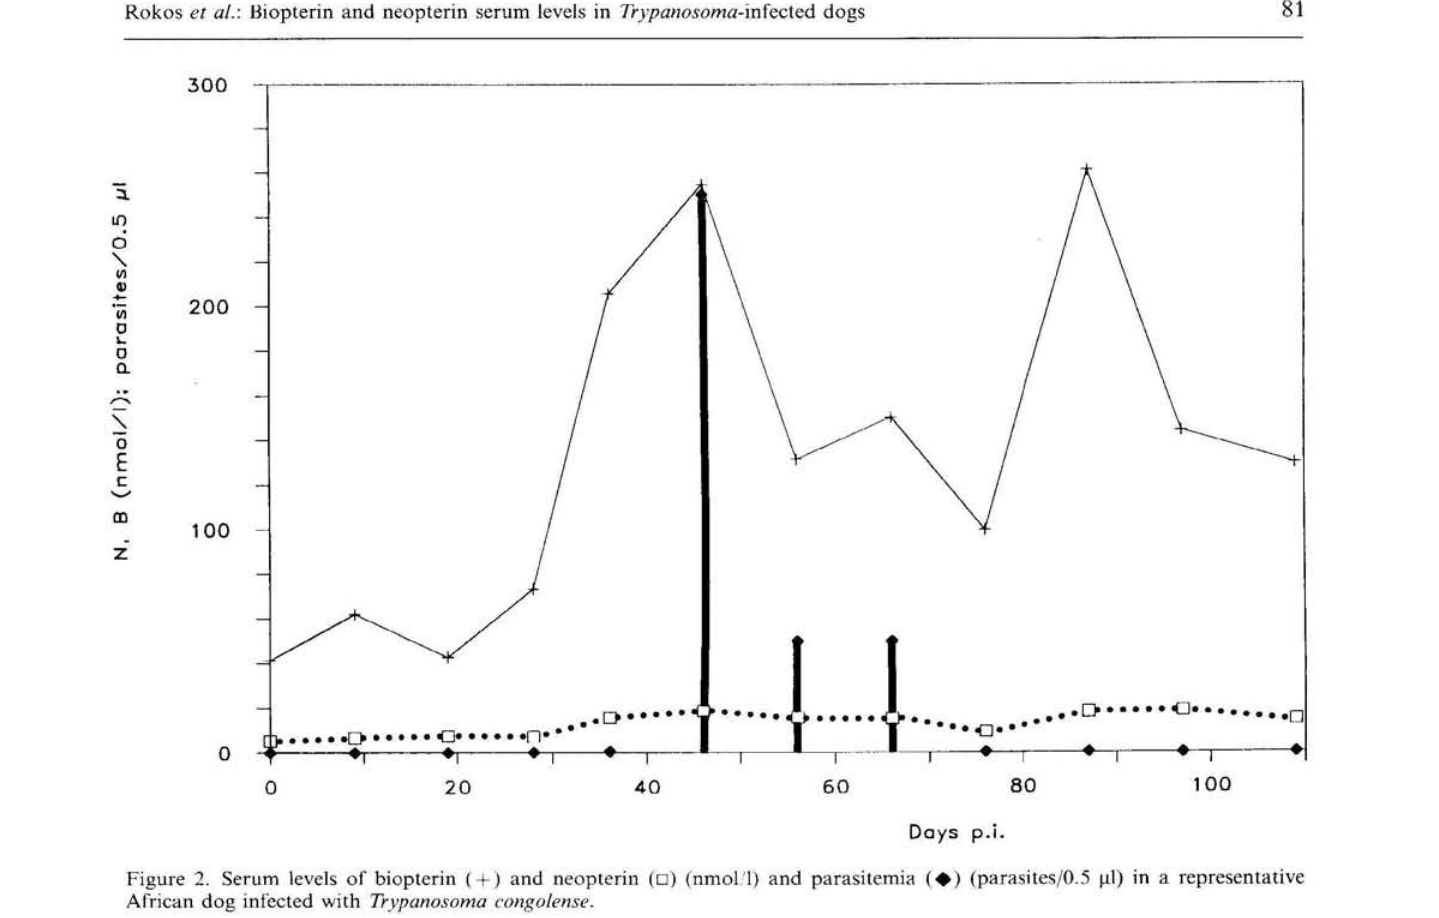
Figure 2. Serum levels of biopterin ( + ) and neopterin (•) (nmol/l) and parasitemia ( •) (parasites/0.5 μΐ) in a representative African dog infected with Trypanosoma